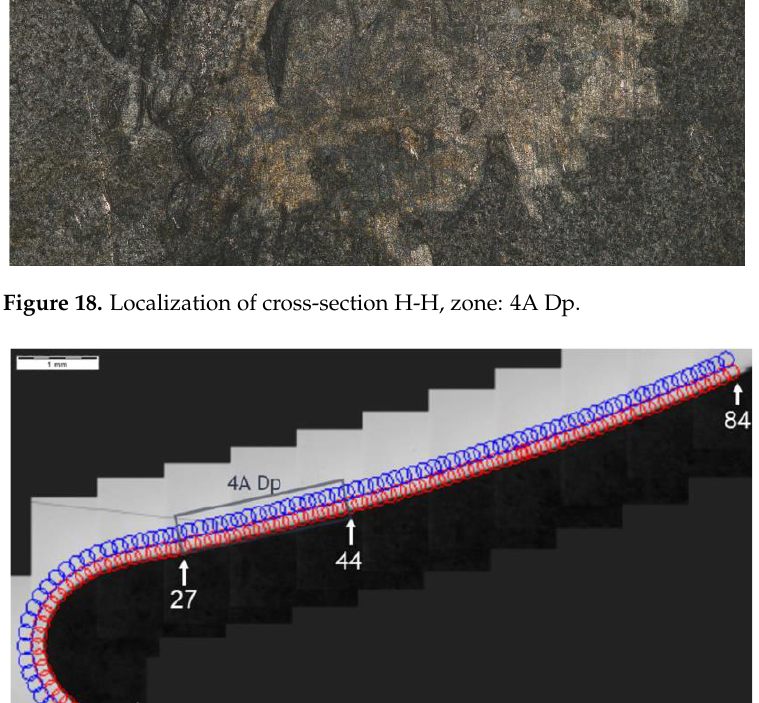
Figure 19. Pattern of hardness verification. Paths depth (distance from tooth surface): 0.1 mm and 0.3 mm. Cross-section H-H, zone: 4A Dp.